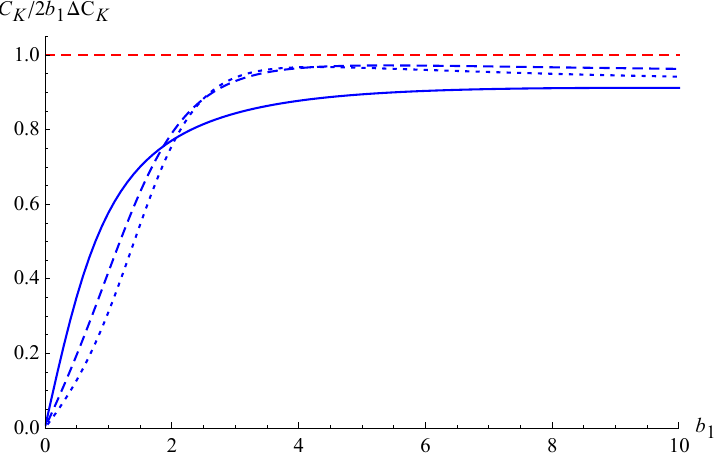
Figure 1 . The ratio of the growth rate of K-complexity to the dispersion bound in operator growth for integrable models b = αn δ , where δ = 3 / 8 (solid), 2 / 3 (dashed) and 3 / 4 (dotted). The horizontal n line stands for the cases in which the bound is saturated during the evolution. It is immediately seen that even if for these models, the bound is not saturated asymptotically, complexity still grows fast, with the rate of change in the same order of the dispersion